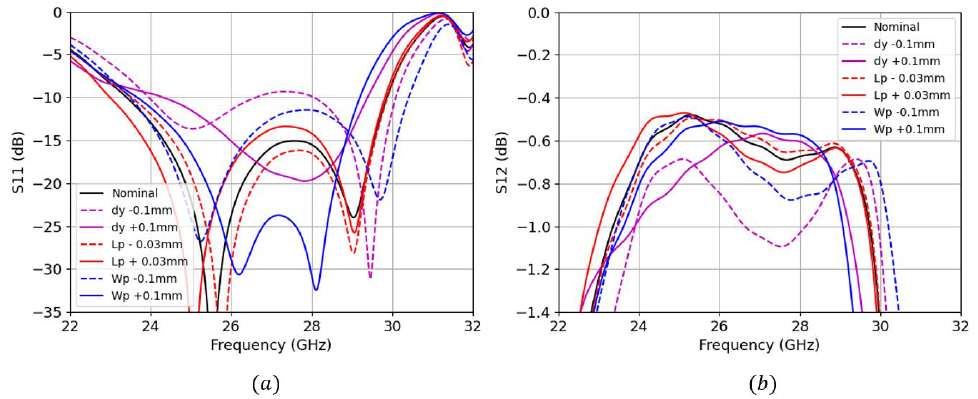
Figure 6. Bottom-side parametric study of S-parameters ( a ) input reflection coefficient ( b ) inser- tion